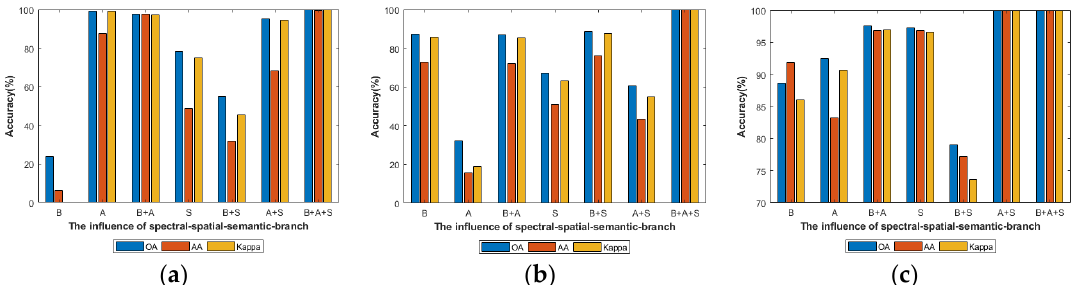
Figure 17. The influence of spectral, spatial and spectral-spatial-semantic stream. ( a – c ) represent the influence of spectral, spatial and spectral-spatial-semantic stream on IN, KSC and SA respectively.